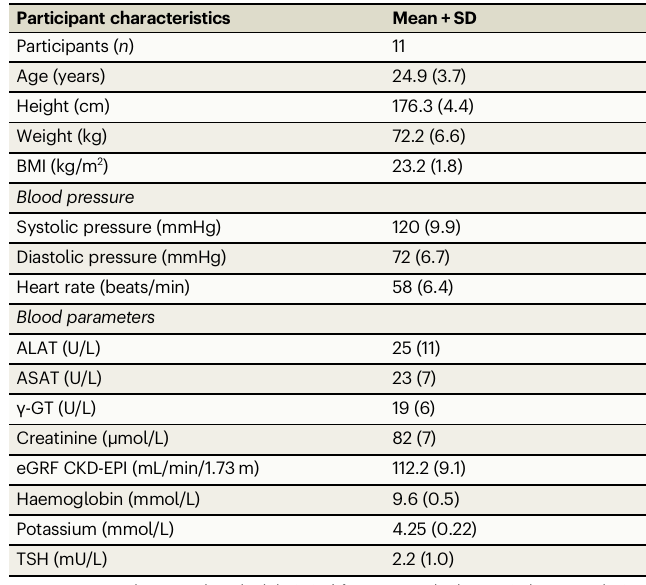
Table 1 | Participant characteristics at screening Participant